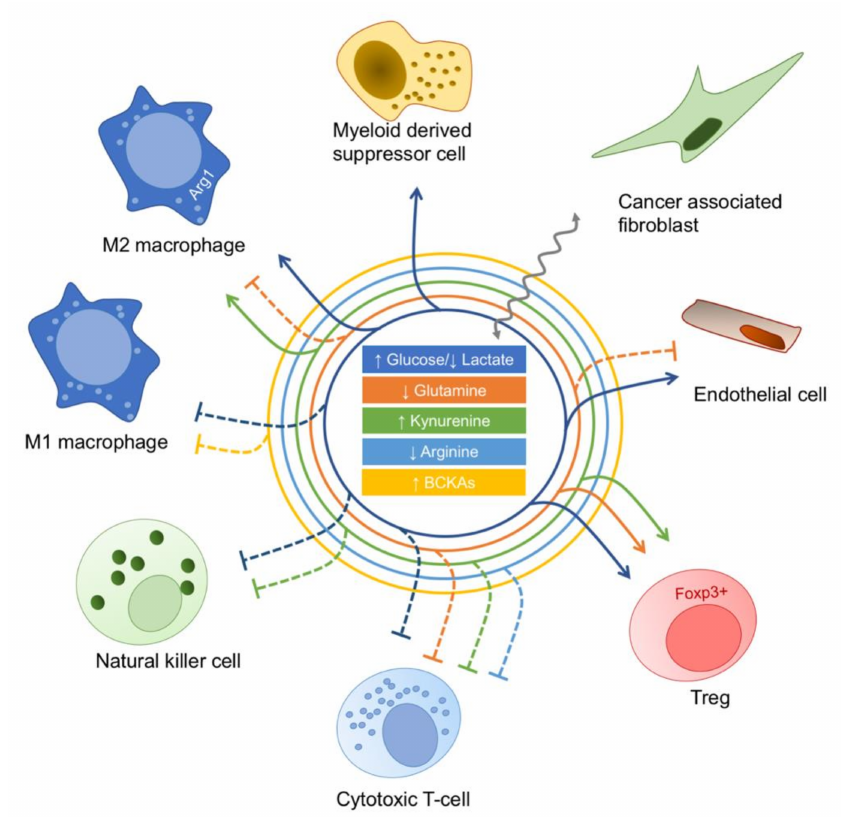
Figure 2. The consequences of cancer cell metabolic reprogramming on the non-malignant pop- ulations of TME. Nutrient shortage and increased amounts of cancer cell metabolic by-products modulate the phenotype of TME cell populations. Full and dashed lines indicate, respectively, stimulation and inhibition. Wavy line represents metabolite exchange between cancer-associated fibroblasts and cancer